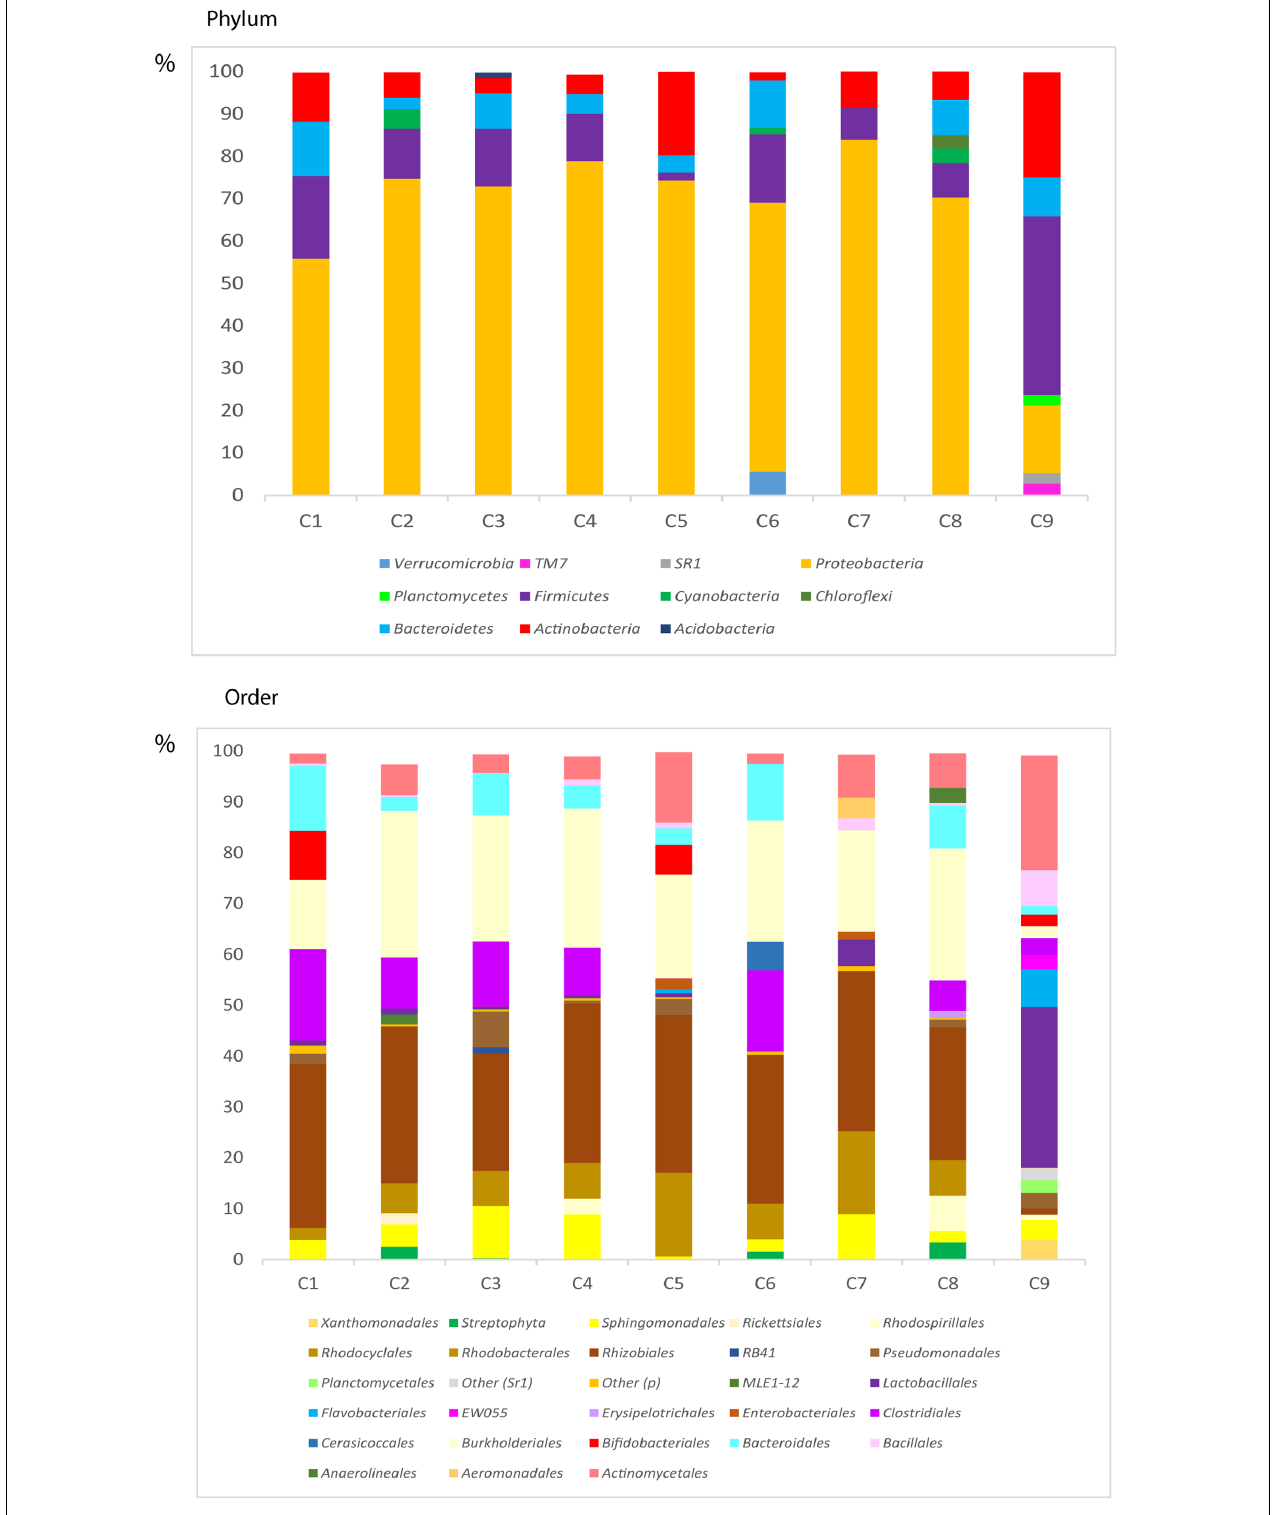
FIGURE 10 | Distribution of bacteria phyla and orders obtained by NGS of DNA from control subjects. Computational analyses of the sequences obtained on the Illumina platform using Qiime classified the data into bacteria phyla and orders. (Upper) Shows the results of bacteria phyla obtained from ERH samples of nine control subjects. (Lower) Shows the results of bacterial orders obtained from ERH samples of nine controls.